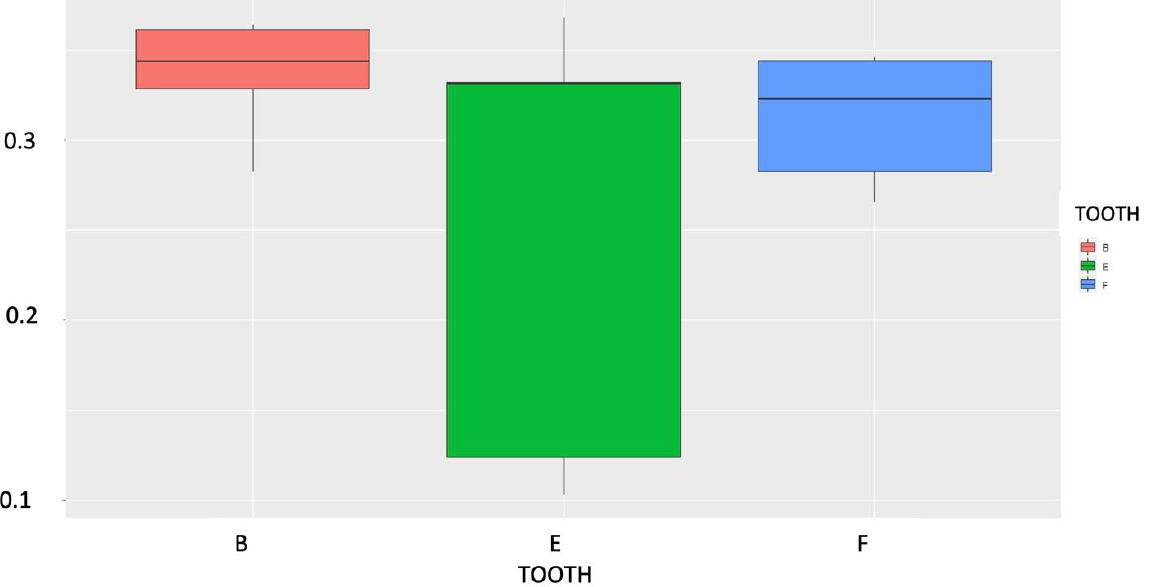
Figure 3. Box-plot regarding ‘Toothpaste B’. Tooth B, E and F represents tooth condition as in Table 1.